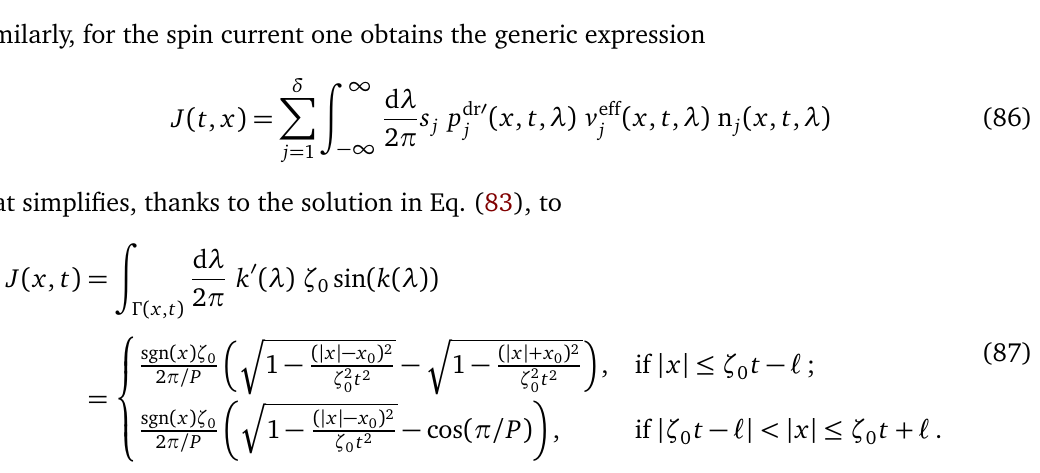
Figure 9: Snapshots of the entanglement profiles during the double DW melting dynamics for different values of the interaction coupling γ . The data are obtained with tDMRG for a system of size L = 225 and (cid:96) = 35, and correspond to the charges profiles shown in Fig.